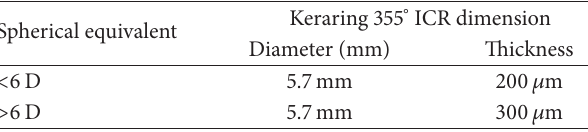
Table 1: Keraring 355 ∘ ICR